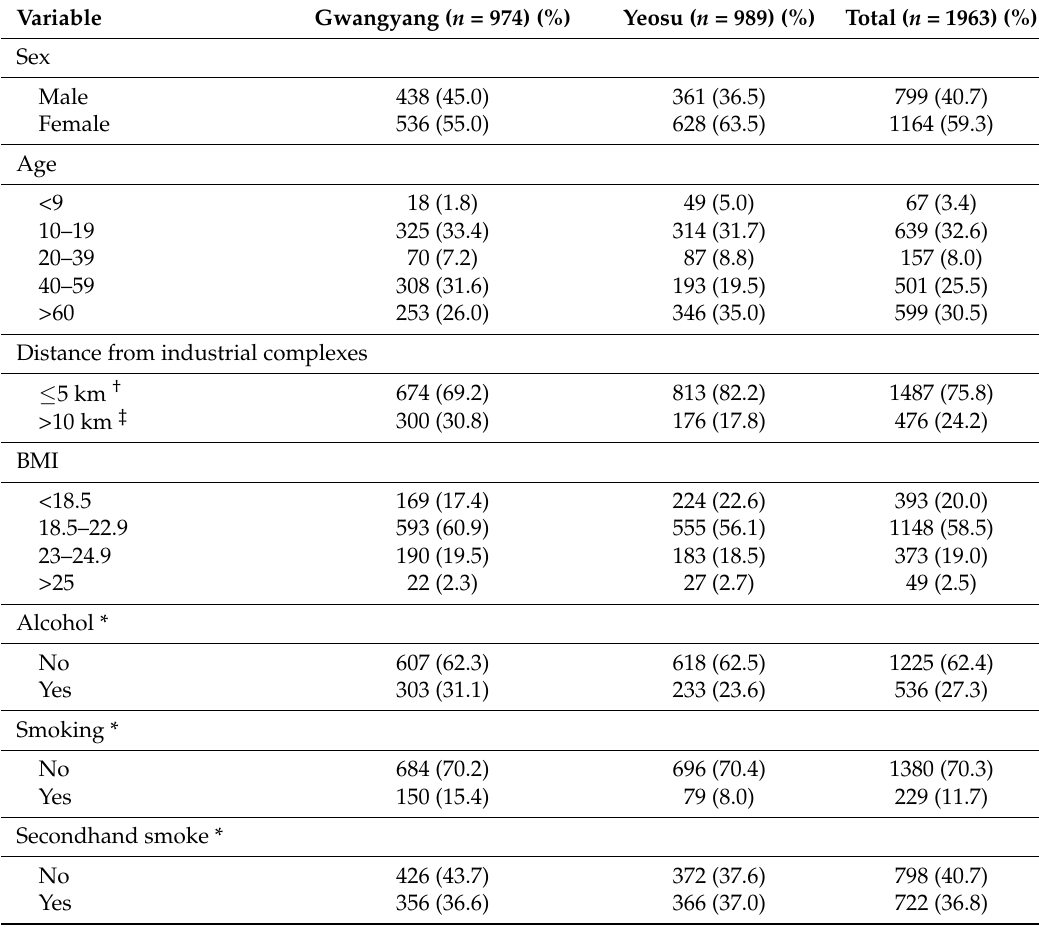
Table 2. Characteristics of the community-based population in Gwangyang and Yeosu cities in Korea.